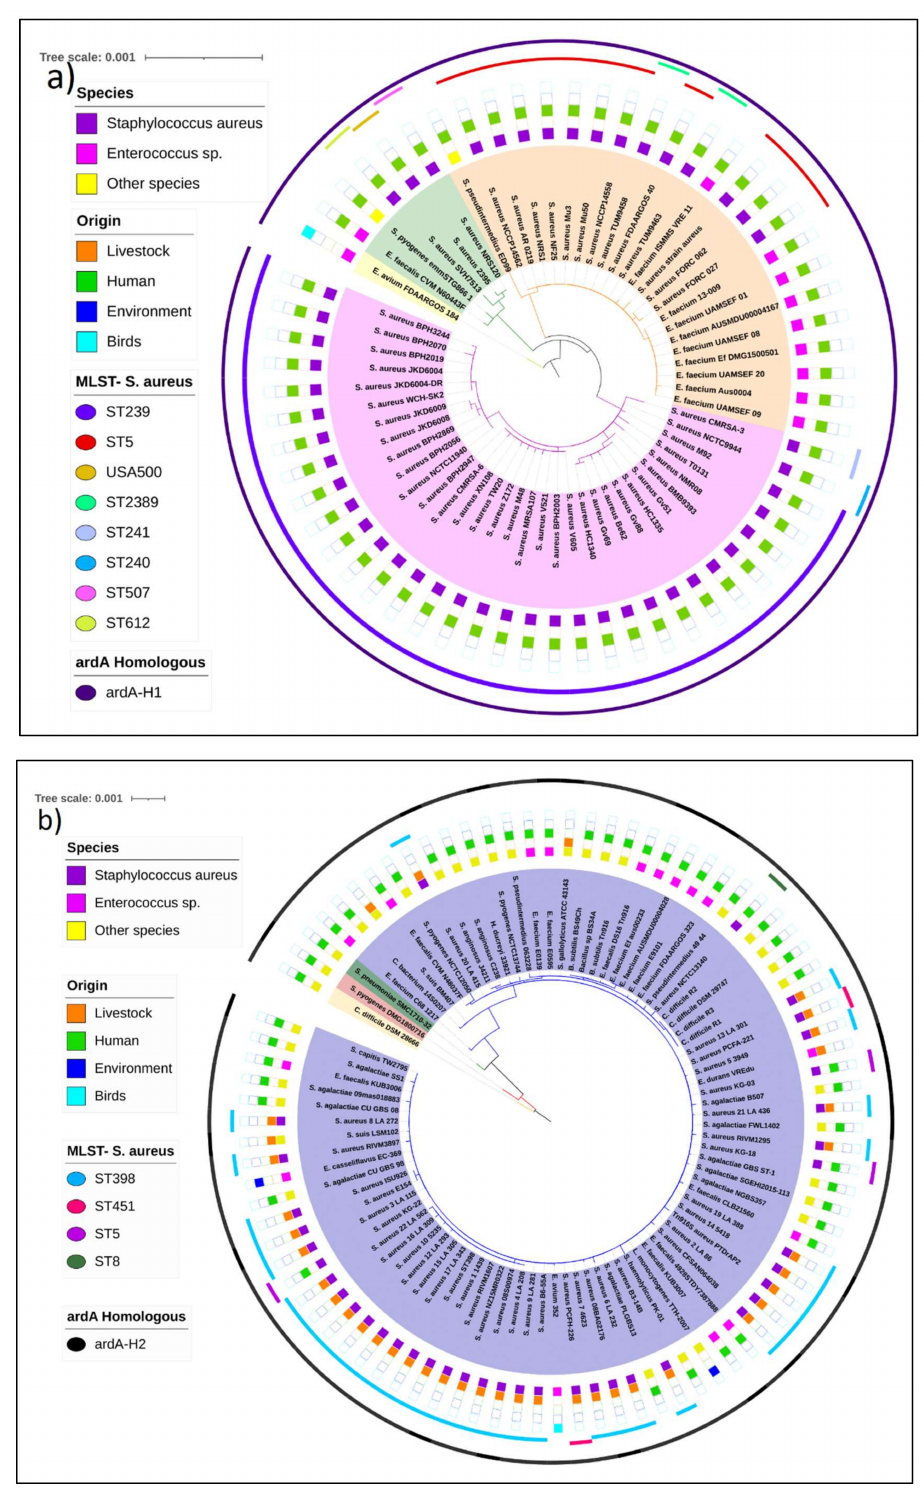
Figure 3. Maximum likelihood phylogenetic tree constructed based on SNP calling, using the nucleotide sequence of Tn 5801 ( a ) and Tn 916 ( b ) from Gram-positive bacteria. The innermost rectangles represent bacterial species, and the outermost represent the origin. The innermost lines represent the sequence type of the multilocus sequence typing, and the outermost lines represent the presence of ardA -H1 and